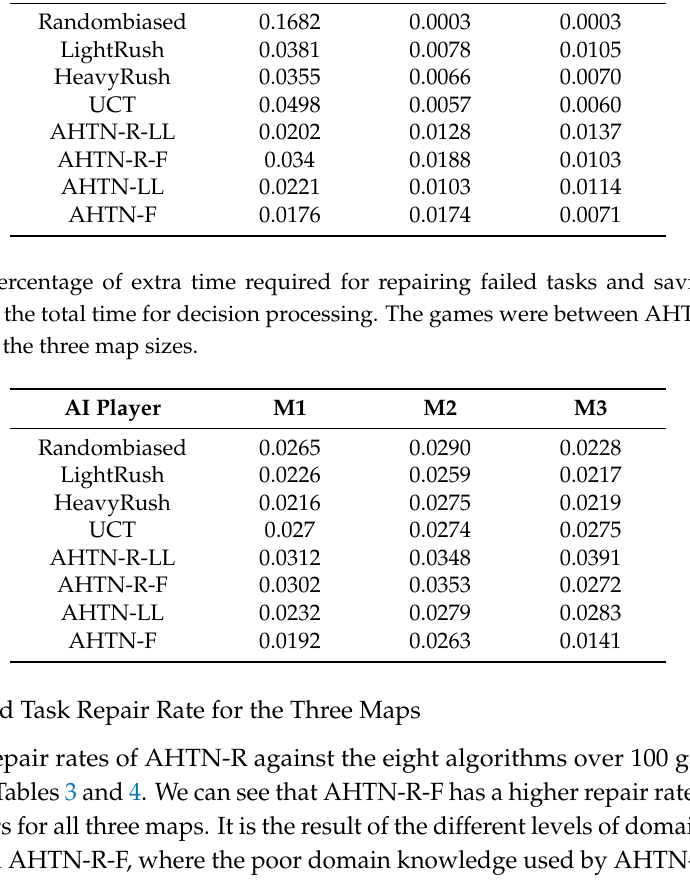
Figure 12. The average decision times of AHTN-R and AHTN with the two types of HTNs obtained over 100 games against each of the 8 algorithms, where the CPU time is 100 ms for map M3 (16 × 16 tiles). The playout time is 100 cycles. Table 1. The percentage of extra time required for repairing failed tasks and saving alternative plans relative to the total time for decision processing. The games were between AHTN-R-LL and the 8 algorithms for the three map sizes (M1 is 8 × 8 tiles, M2 is 12 × 12 tiles, and M3 is 16 × 16 tiles). AI Player M1 M2 M3 Randombiased 0.1682 0.0003 0.0003